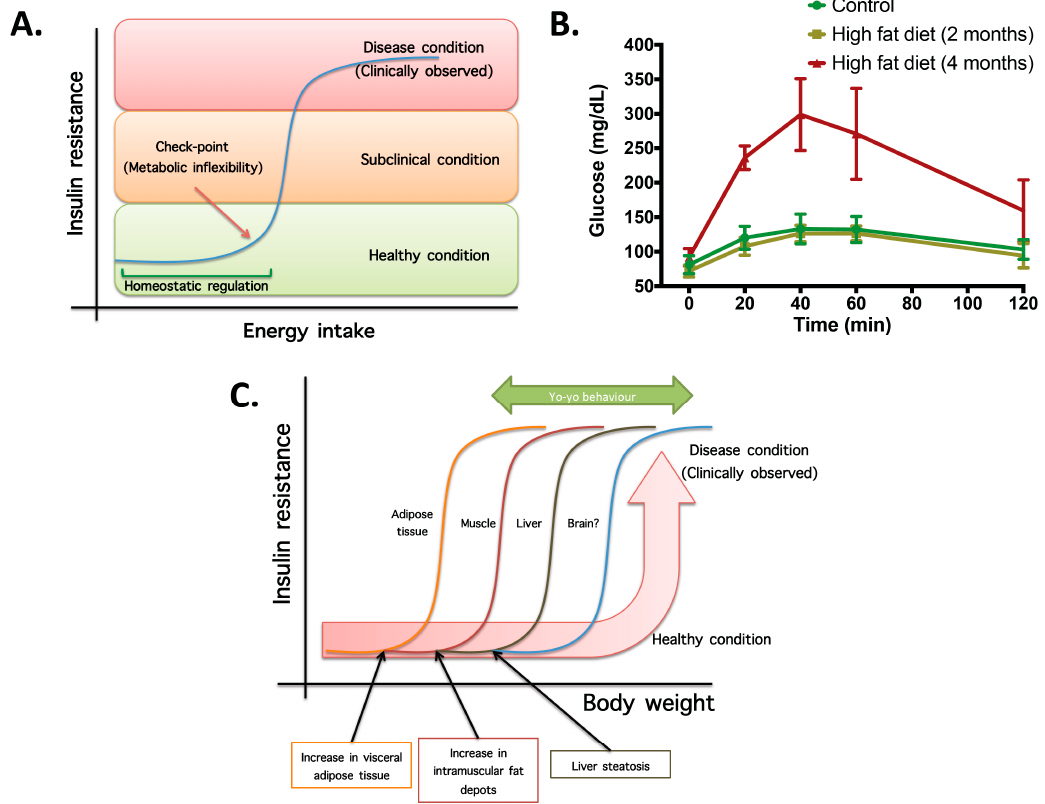
Figure 1. The concept of metabolic inflexibility and disease related outcomes. ( A ) Scheme of high-energy intake homeostatic regulation until a checkpoint, where energy storage systems are overloaded and subclinical and pathological conditions are observed. ( B ) Plasma glucose levels during a sub-cutaneous glucose tolerance test (2 g glucose/kg body weight) in controls and mice fed with a high-fat diet (34%) for two and four months. Insulin resistance, measured by means of blood glucose, is observed at four months of high-fat intake, whereas at two months, homeostatic compensation is still observed (unpublished observations). ( C ) Scheme of metabolic flexibility checkpoints in different organs for which, after passing organ-specific conditions, pathological features are observed. This explains the rapid change in metabolic flexibility after a weight reduction program and the yo-yo effect if the weight reduction is not maintained.